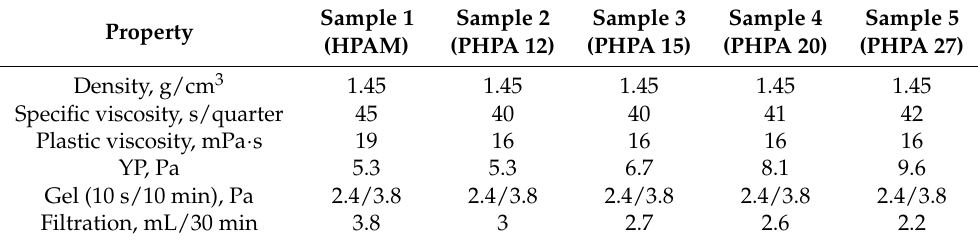
Table 3. Parameters of the investigated drilling fluids.